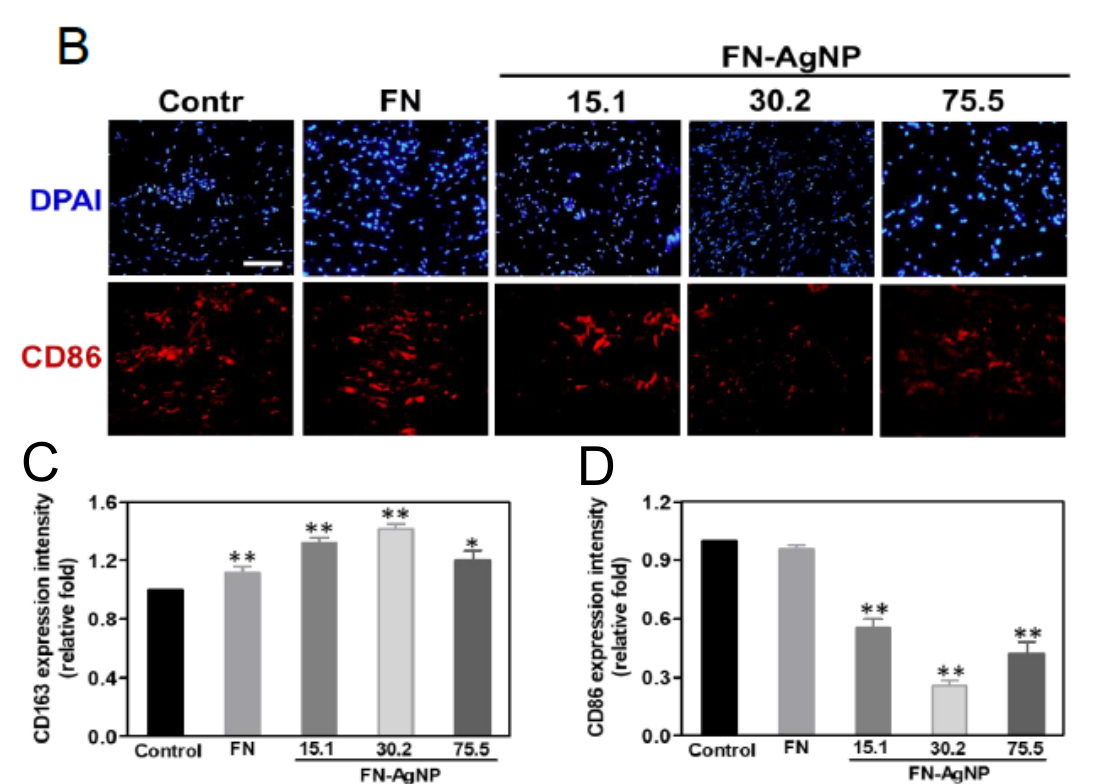
Figure 8. Images of immunohistochemistry staining for macrophage polarization after four weeks subcutaneous implant- ation. ( A , B ) The IHC staining for markers of macrophage, CD163 (M2, green color) and CD86 (M1, red color), were inves-tigated after implanting various materials. ( C ) The expression of CD163 was semi-quantified. * p < 0.05; ** p < 0.01: greater than the control ( n = 5). ( D ) The expression of CD86 was also analyzed resulting from fluorescence intensity. * p < 0.05; ** p < 0.01: less than the control. cell nucleus was located by DAPI (blue color). Control group = glass cover slide. Scale bar = 100 µ m. Data are presented as mean ± SD ( n = 5).